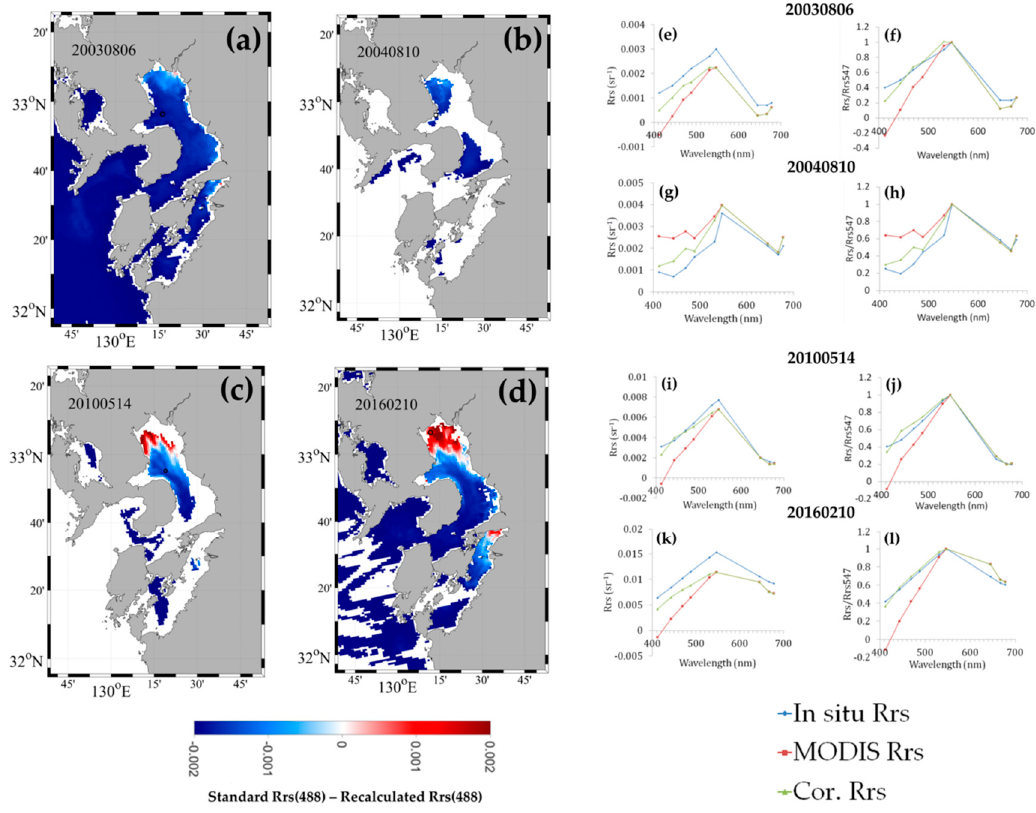
Figure 5. Spatial distributions of the difference between recalculated and standard MODIS Rrs(488), and comparison of Rrs and normalized Rrs for in situ, standard, and recalculated data indicated by blue, red, and green color, respectively; ( a ) 6 August 2003, ( b ) 10 August 2004, ( c ) 14 May 2010, and ( d ) 10 February 2016. Right panels showed the examples of the spectra of match-up locations; ( e , f ) 6 August 2003, ( g , h ) 10 August 2004, ( i , j ) 14 May 2010, and ( k , l ) 10 February 2016. The black symbol in ( a – d ) represents the locations from where the Rrs spectra was